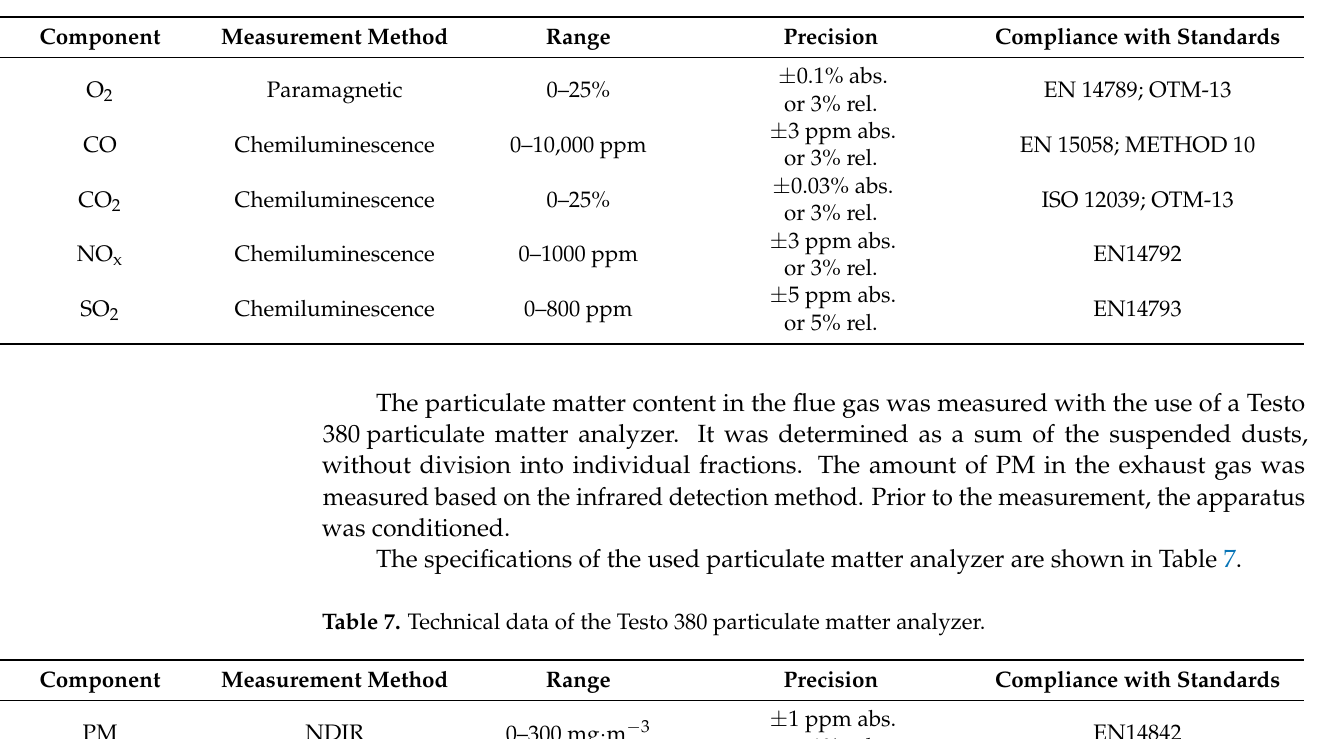
Table 6. Technical specifications of the Testo 350 flue gas analyzer.